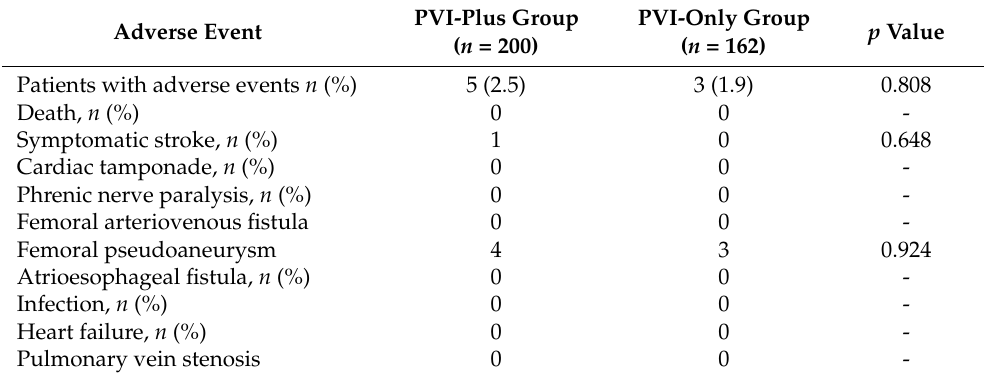
Table 3. Adverse Event.